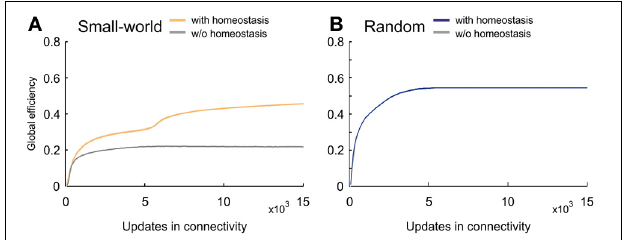
FIGURE 11 | Global efficiency changes over time due to network development. (A) Small-world networks with (orange) and without (gray) homeostasis in electrical activity. (B) Random networks with (blue) and without (gray) homeostasis in electrical activity. Means over five simulations per scenario. Shadings of the curves indicate standard